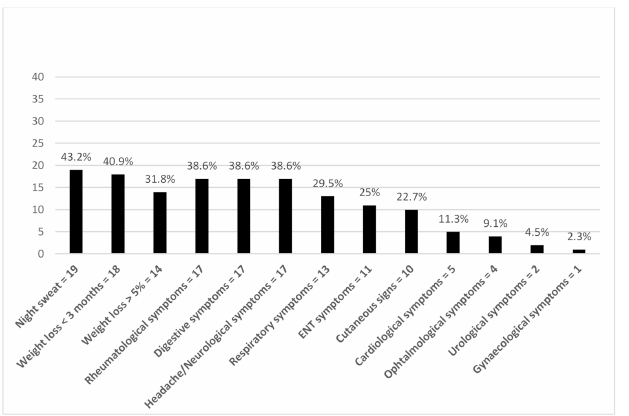
Figure 1. Clinical symptoms of the study population. (Abbreviation: ENT, ear, nose, and